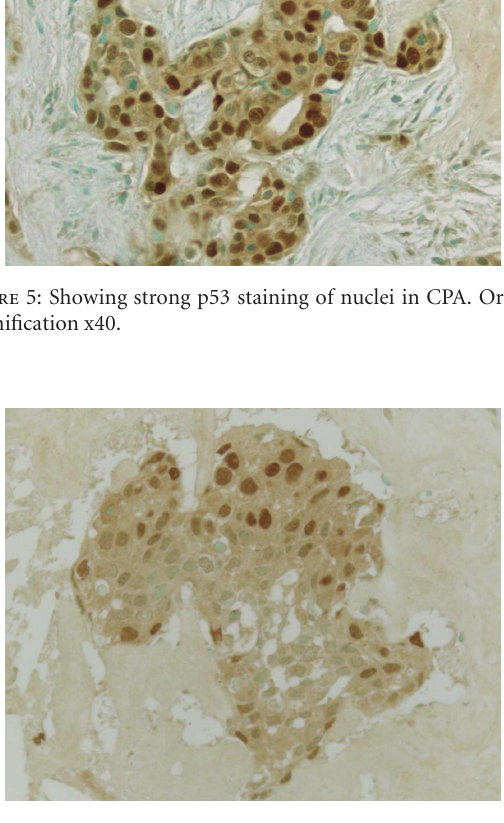
Figure 6: Showing moderate p53 nuclear staining in CPA. Original magnification